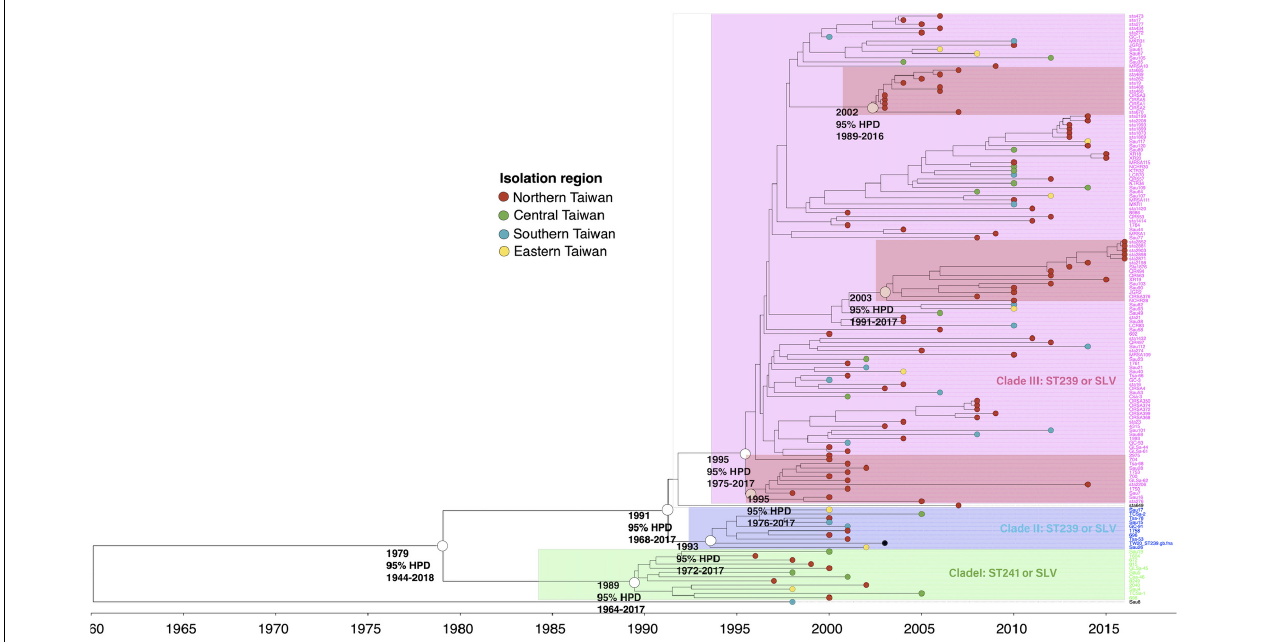
FIGURE 1 | Time-scaled phylogeny of 140 methicillin-resistant Staphylococcus aureus isolates of the ST239/241 lineage collected in Taiwan during 1996 and 2016. Three major clades were marked with different colors. The hollow circles indicate the most recent common ancestors of the isolates of the indicated clade and its estimated year of appearance. The isolates of three subclades that emerged in 1995, 2002, and 2003 (marked as dark red) were identified in northern Taiwan, suggesting a local transmission of the strains. HPD, highest posterior density; SLV, single-locus variants.